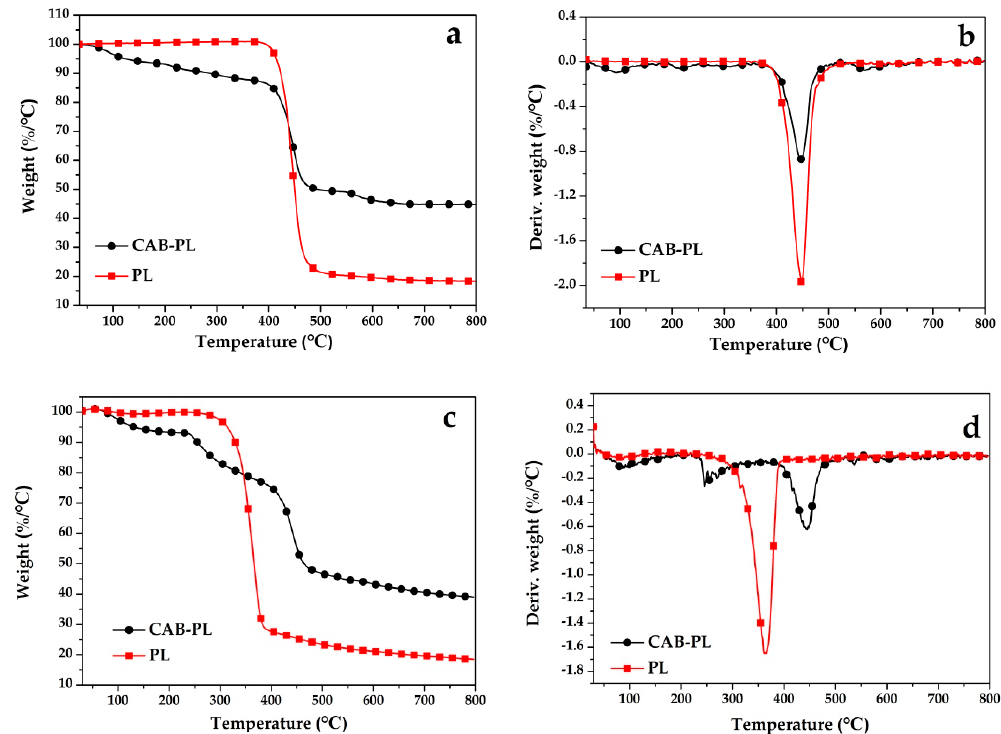
Figure 5. ( a ) TG and ( b ) DTG curves of the CAB-PL and PL under air; ( c ) TG and ( d ) DTG curves of the CAB-PL and PL under N 2 .